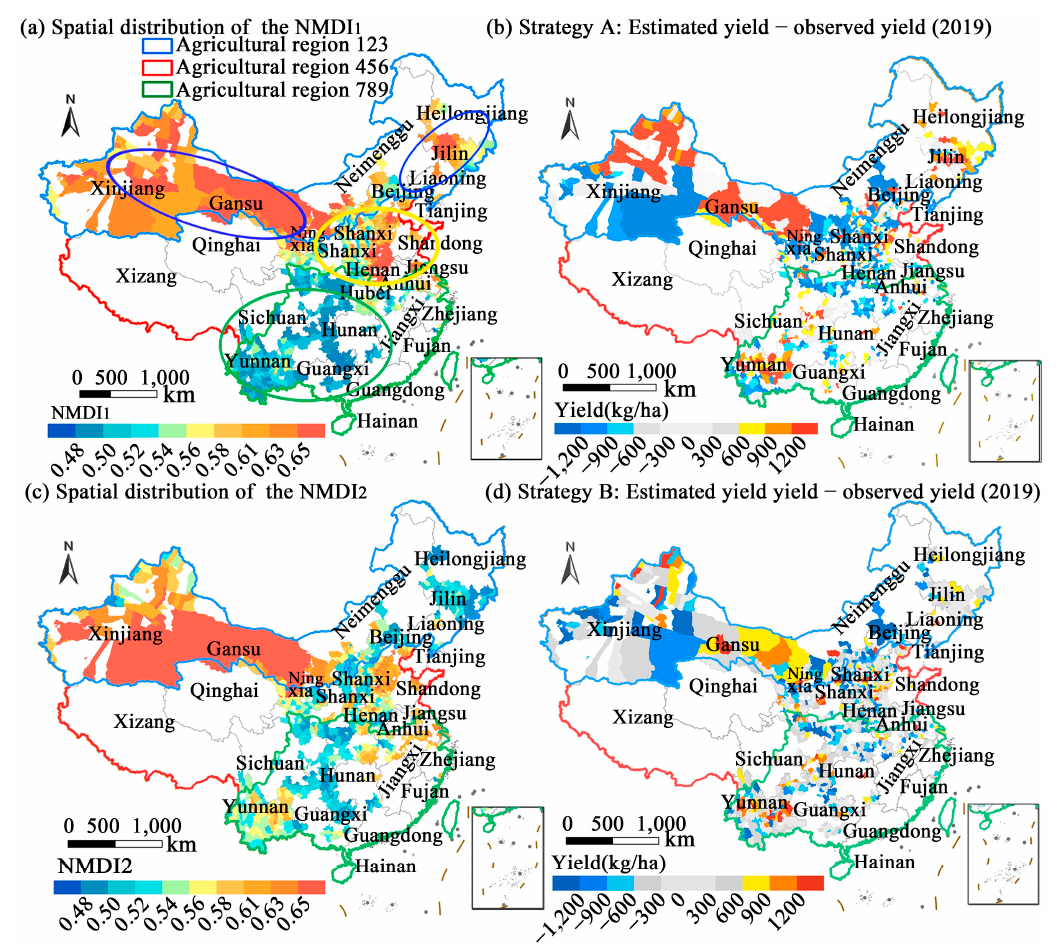
Figure 9. Strategy A: ( a ) spatial distribution of NMDI 1 and ( b ) distribution of the differences between observed and estimated yields; Strategy B: ( c ) spatial distribution of NMDI 1 and ( d ) distribution of differences between observed and estimated yields. Note: NMDI 1 represents the value of the vegetative growth period; NMDI 2 represents the value of the reproductive growth period; and the others are similar.